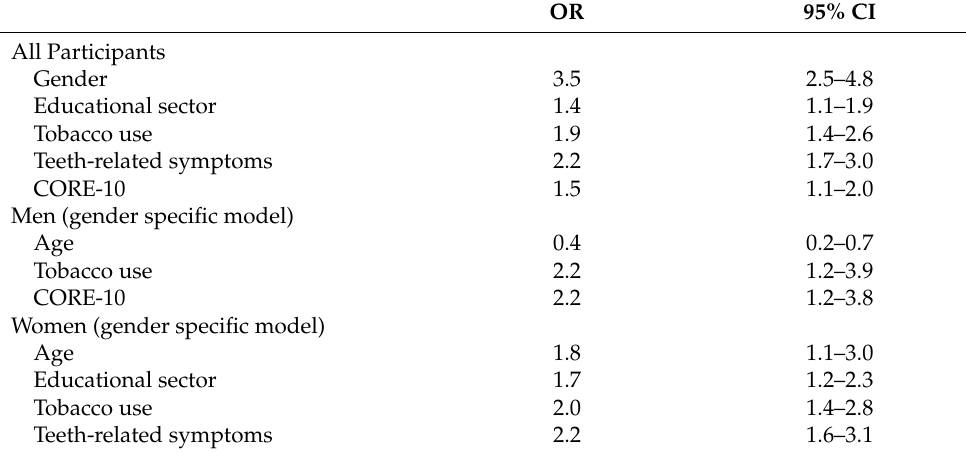
Table 4. Results of logistic regression analyses including CORE-10 as a measure of psychological distress, dental fear as a dependent variable (not at all or somewhat afraid = 0, very afraid = 1).